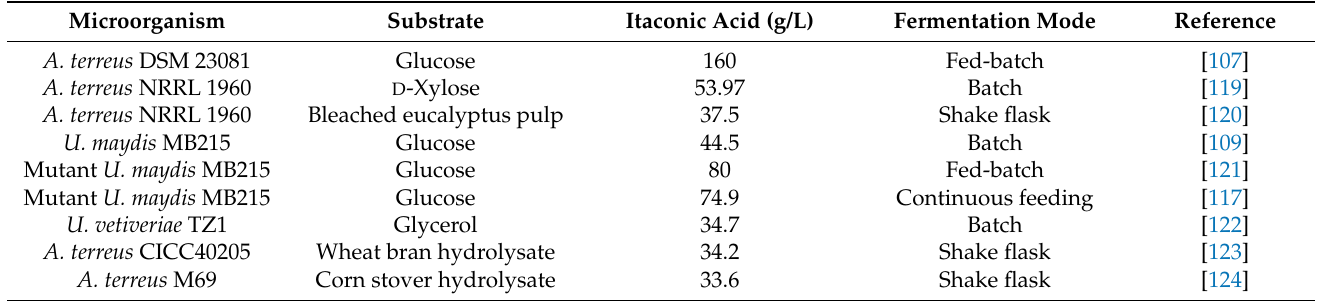
Table 4. Itaconic acid production with different substrates, microorganisms, and fermentation